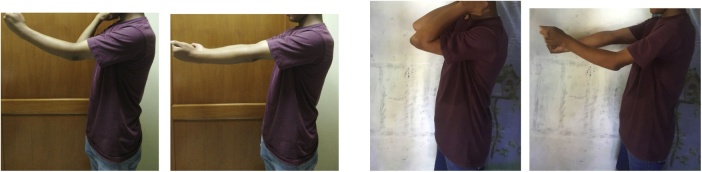
Elbow's ROM comparison preoperative (flexion-extension 300–00) and 6 months postoperative (flexion-extension 1100–300).